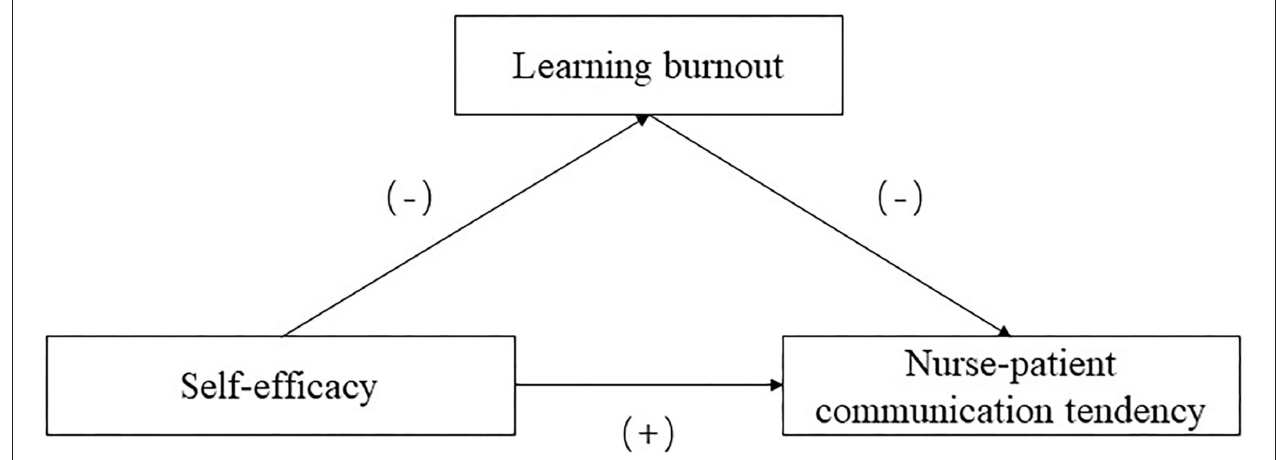
FIGURE 1 | Conceptual